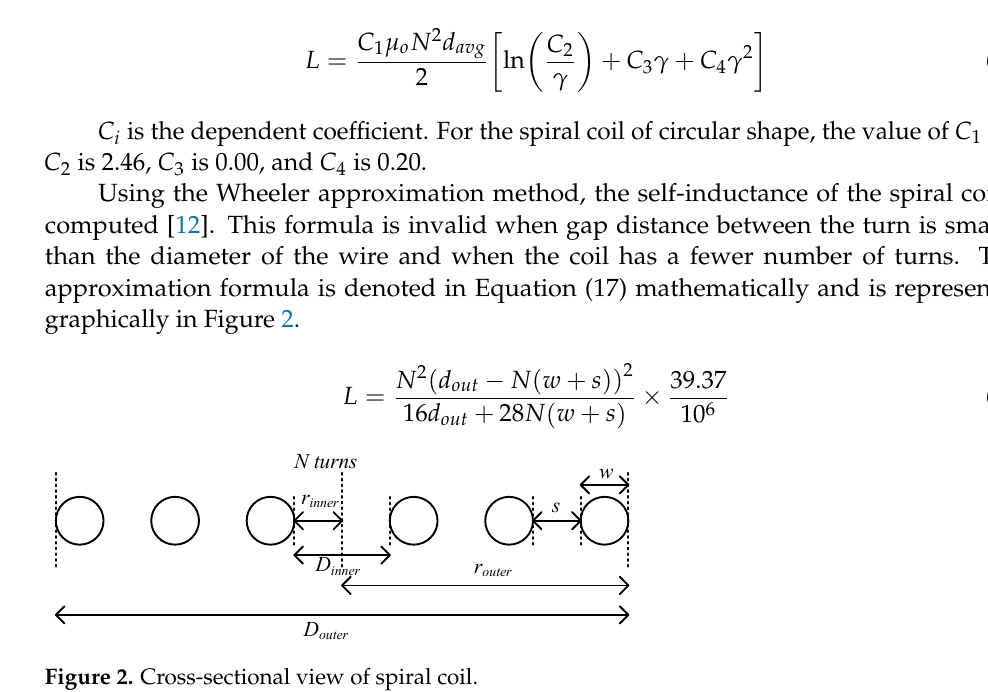
Figure 2. Cross-sectional view of spiral coil.